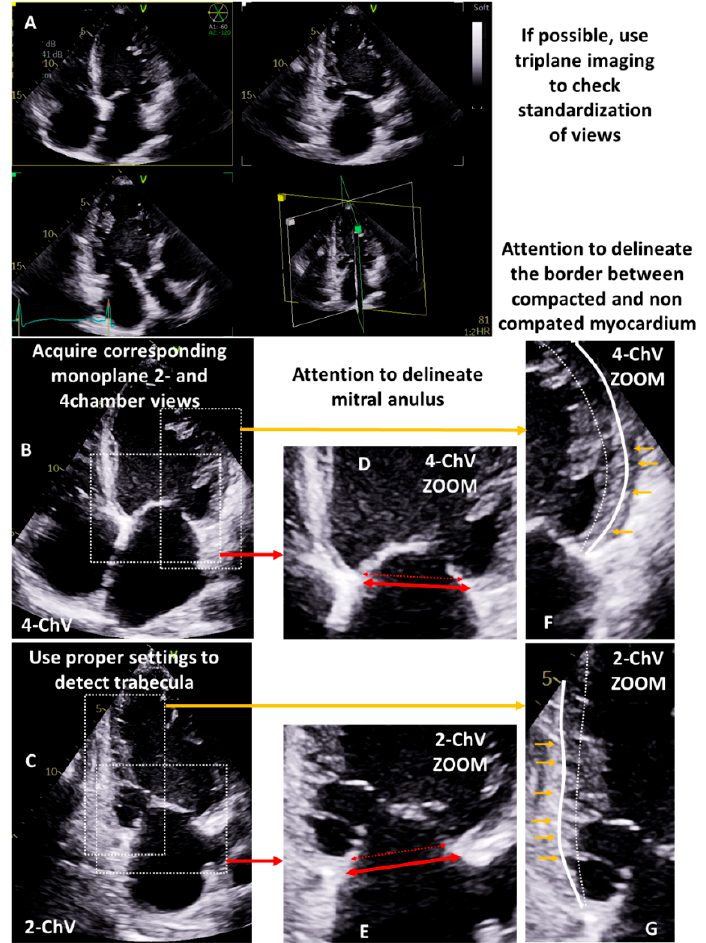
Figure 1. Instructions for proper 2D planimetry or 3D volumetry of the LV cavity. Firstly, check the standardization of apical views by using triplane imaging ( A ). Secondly, acquire comparable monoplane two- and four-chamber views (2-ChV, 4-ChV) with high spatial resolution to ensure proper visualization of cardiac structures ( B , C ). Thirdly, properly performed the delineation of mitral anulus—the proximal mitral leaflets normally do not represent the level of mitral anulus (D-Zoom area is labeled by dotted rectangles; the dotted red double arrow displays an improper labeling of the mitral anulus, the solid red double arrow the proper labeling) ( D , E ). Fourthly, identify interven- ing spaces between myocardial trabecula (small orange arrows) to delineate the border between compacted and non-compacted myocardium (( F )—4-ChV, ( G )—2-ChV; zoom areas are labeled by dotted rectangles; the small orange arrows display the endings of the interspaces between the tra- becula; the dotted white lines display an improper labeling of the compacted myocardium; the solid white line displays the proper labeling).